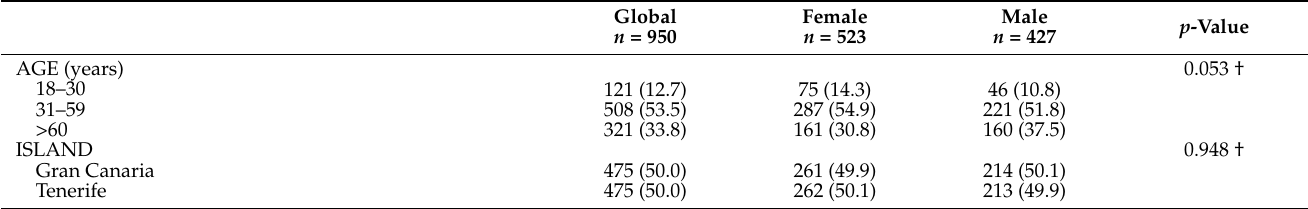
Table 1. Global and per gender